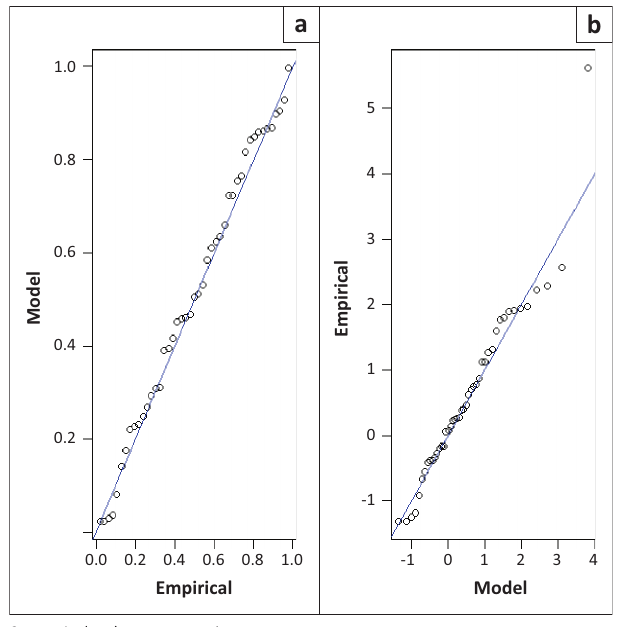
years and x = x is the AM flood height. The diagnostic i, ∀ i =1,2,…, k plots for the time-heterogeneous models in Eqn (10) and